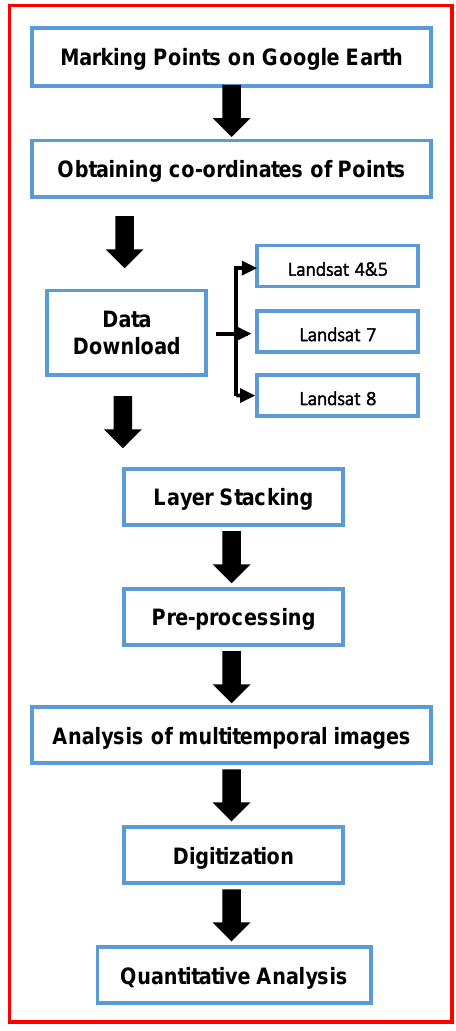
Figure 2. Protocol devised for the study